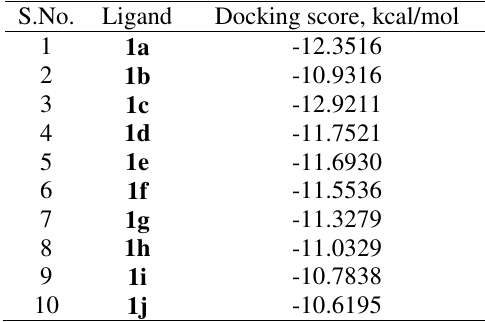
Table 2. Docking score (kcal/mol) of different flavone ligands 1a-j with HMT (pdb ID: 2aot)